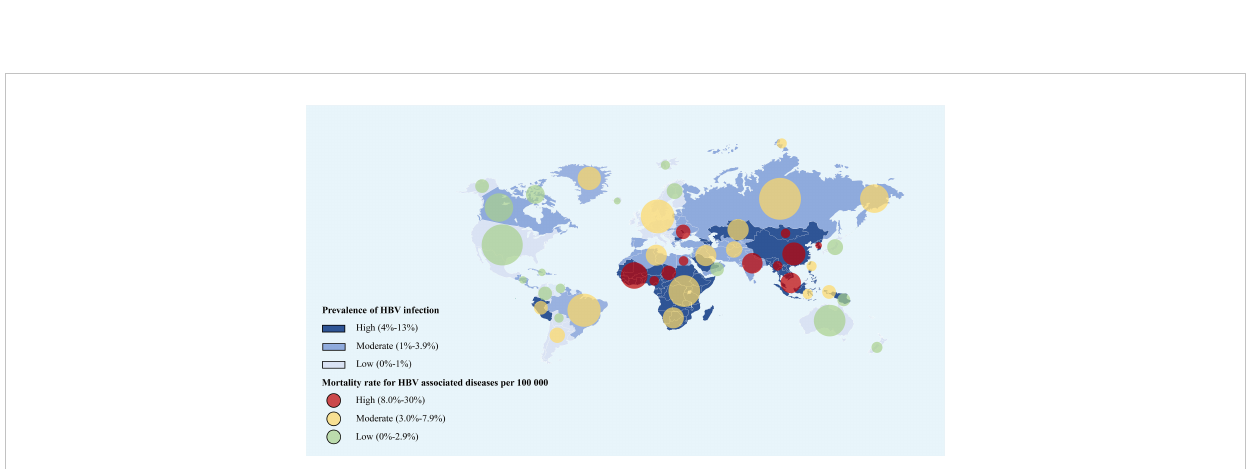
FIGURE 2 The global prevalence of HBV infection and all-age death rate for HBV associated diseases per 100,000 in 2019 (refers to the Global Burden of Disease Study 2019) (1). The east Asian countries and African countries showed the highest HBV infection rate as well as the mortality rate around the world. This fi gure was drawn with the tool of “ Smart Art ” by Dr. Xiaoyuan Wei. HBV, hepatitis B virus.